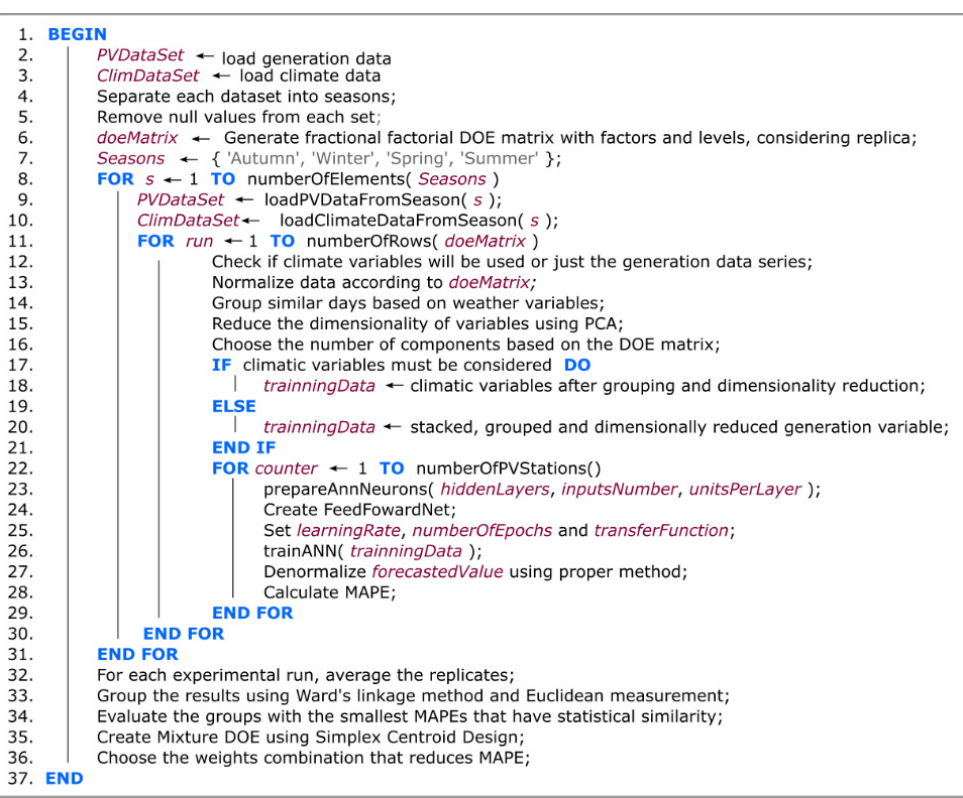
Figure 9. Proposed pseudocode to automate the photovoltaic forecasting process. Source: own au- thors.